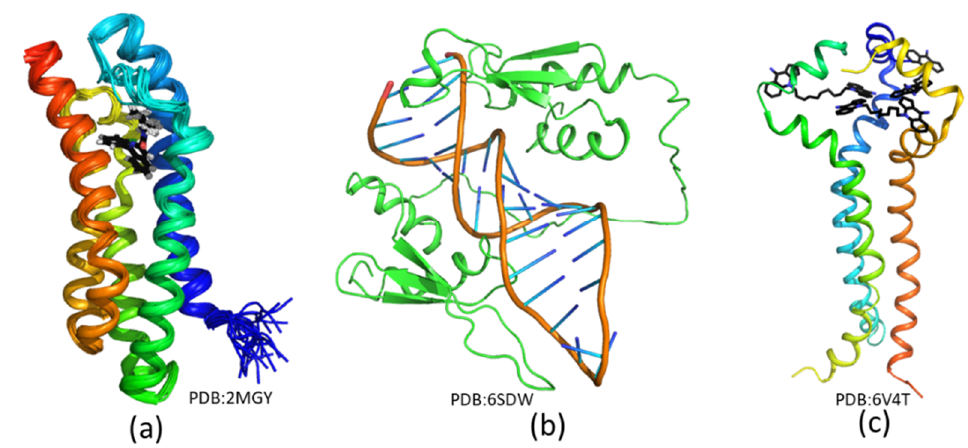
Figure 5. List of several complex structures resolved using solution NMR spectroscopy. ( a ) Solution structure of TPSO in complex with a small-molecule inhibitor [73]. ( b ) Structure of STAU1 dsRBD3/4–sARF1 SBS dsRNA complexes [143]. ( c ) Solution structure of MPER in complex with a small-molecule inhibitor [144]. The small-molecule compounds are shown in black sticks, and the access codes of these structures in the Protein Data Bank (PDB) are indicated in the figure.